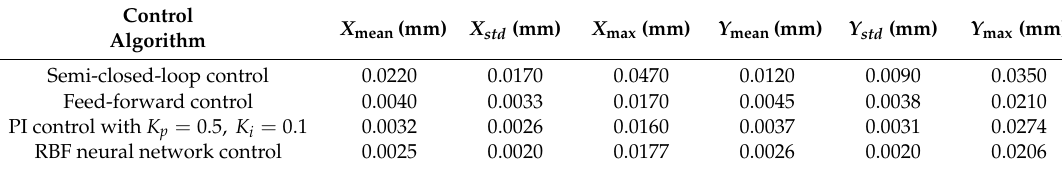
Table 3. Tracking accuracies of different control algorithms. Control Algorithm